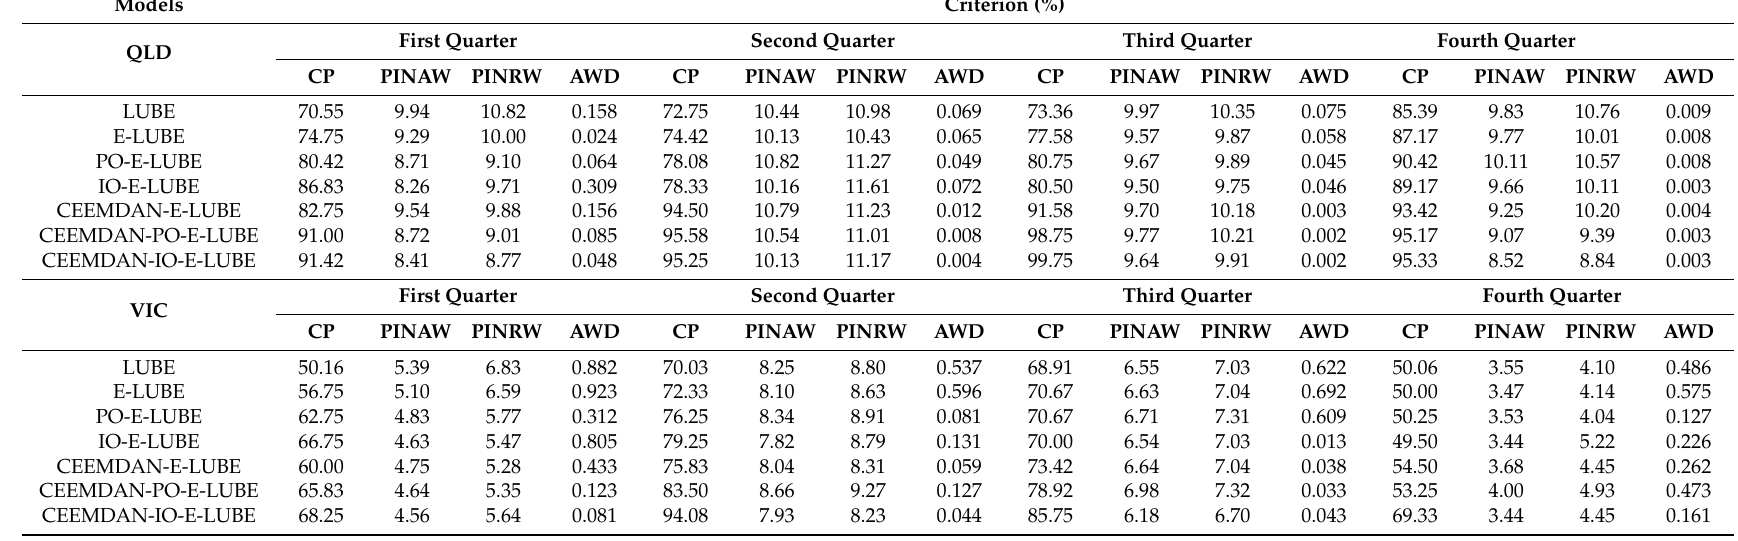
Table 5. Results of different models with α = 0.025 for sample in QLD and